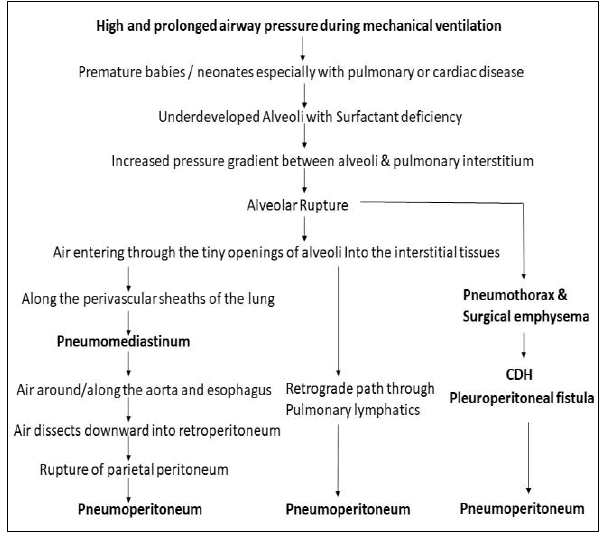
Figure 5: A flow chart to explain the pathogenesis of spontaneous pneumoperitoneum in pediatric